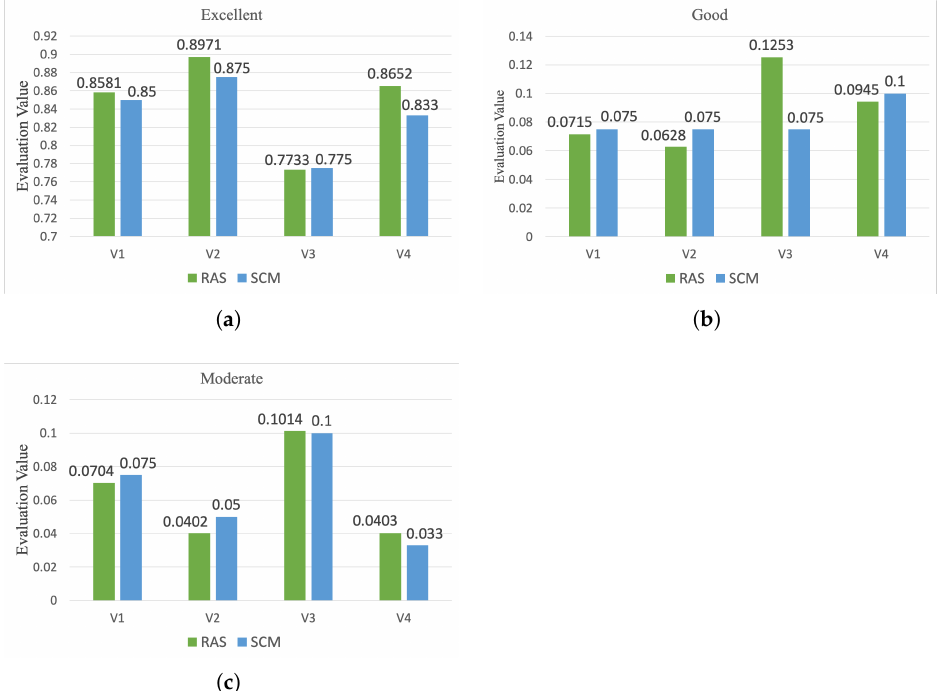
Figure 8. Evaluation analysis of the RAS and SCM in terms of the results for: ( a ) excellent; ( b ) good; and ( c ) moderate.